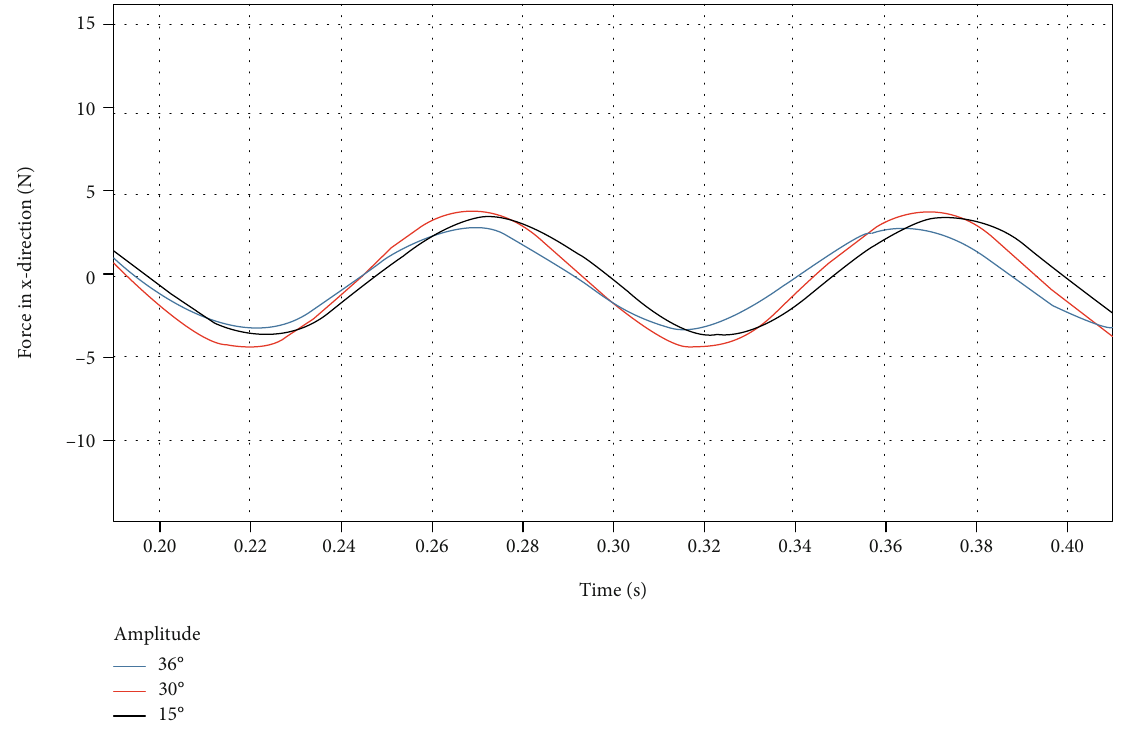
Figure 17: x -direction force on the dorsal fi n at di ff erent swing amplitudes. Table 10: x -direction force parameter values of the dorsal fi n at di ff erent swing